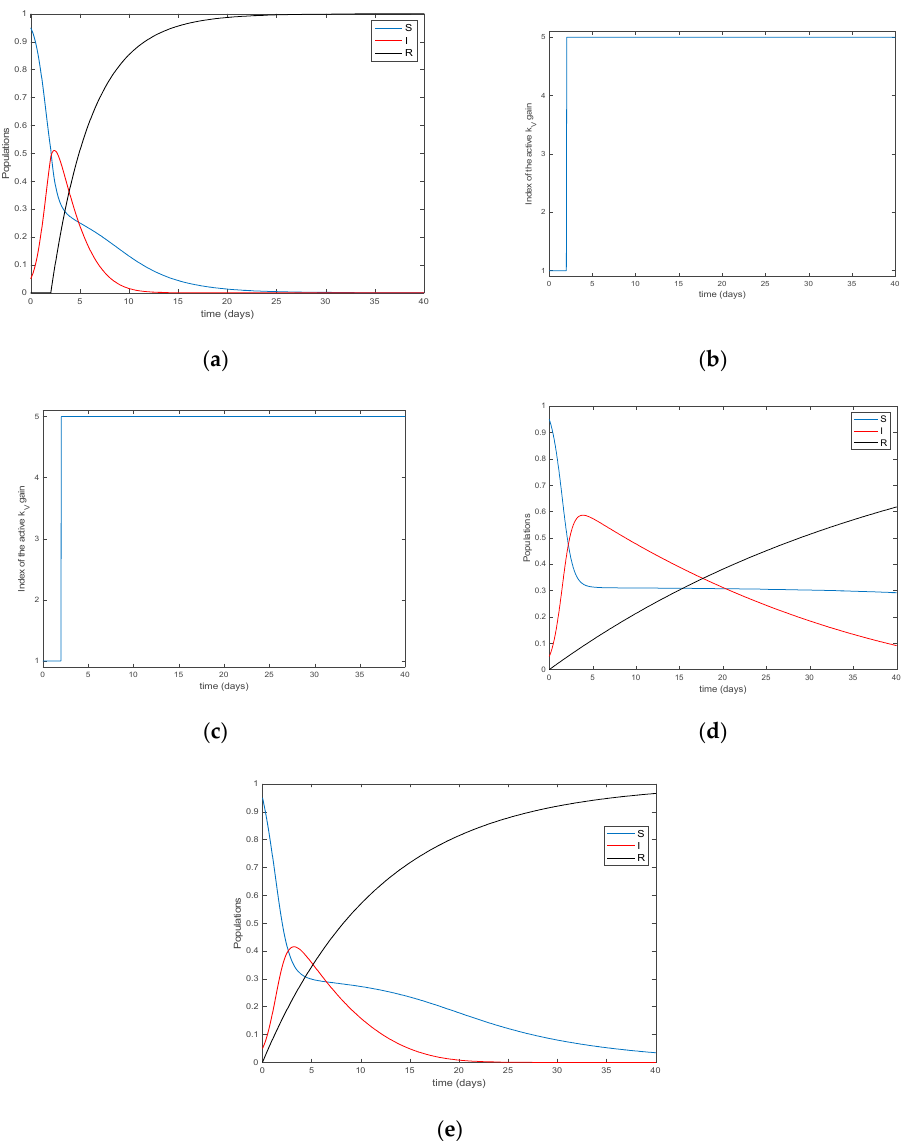
β= 2.5 Figure 2. Performance of the system for β = 2.5 and γ = 0.79 days − 1 when vaccination and treatment Figure 2. Performance of the system for and 790 . =γ days − 1 when vaccination and are included in the model. The control parameters are S KV = S KT = {0 0.001 0.0035 0.0075 0.01}, treatment are included in the model. The control parameters are T min = 2 days and λ = 0.5. The vaccination and treatment e ff orts are selected online via Algorithm 1. = 2 days and λ= 0.5 . The vaccination , T min ( a ) Evolution of model’s populations. The infection is asymptotically removed while the whole and treatment efforts are selected online via Algorithm 1. ( a ) Evolution of model’s populations. The population becomes immune asymptotically. ( b ) Index representing the active vaccination control gain infection is asymptotically removed while the whole population becomes immune asymptotically. ( b ) versus time from S KV , parameterizing the vaccination e ff ort. ( c ) Index representing the active treatment Index representing the active vaccination control gain versus time from , parameterizing the control gain versus time from S KT , parameterizing the treatment e ff ort. ( d ) Evolution of model’s vaccination effort. ( c ) Index representing the active treatment control gain versus time from , populations under constant control gains of k V = k T = 0.001. ( e ) Evolution of model’s populations under constant gains of k V = k T = parameterizing the treatment effort. ( d ) Evolution of model’s populations under constant control = k = 0.001 . ( e ) Evolution of model’s populations under constant gains of gains of k V T = k = 0.035 . k V T